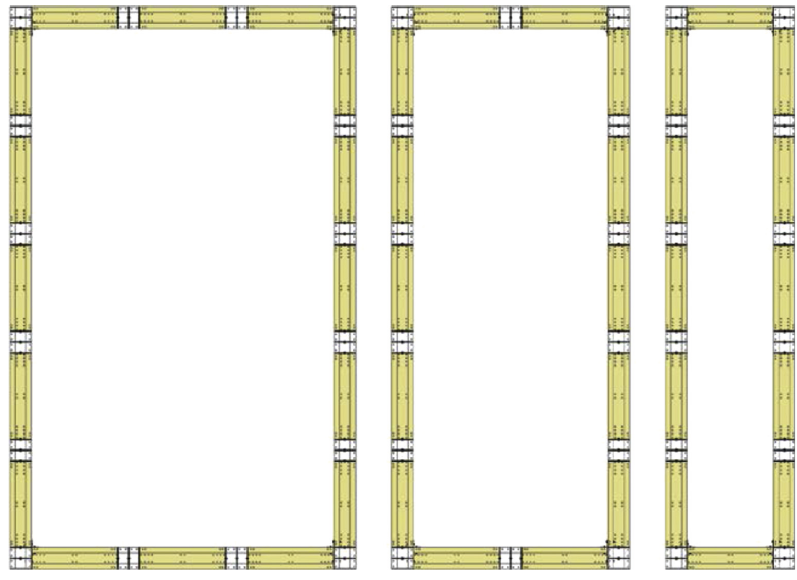
Figure 18: Wall frames: F18M, F12M, and